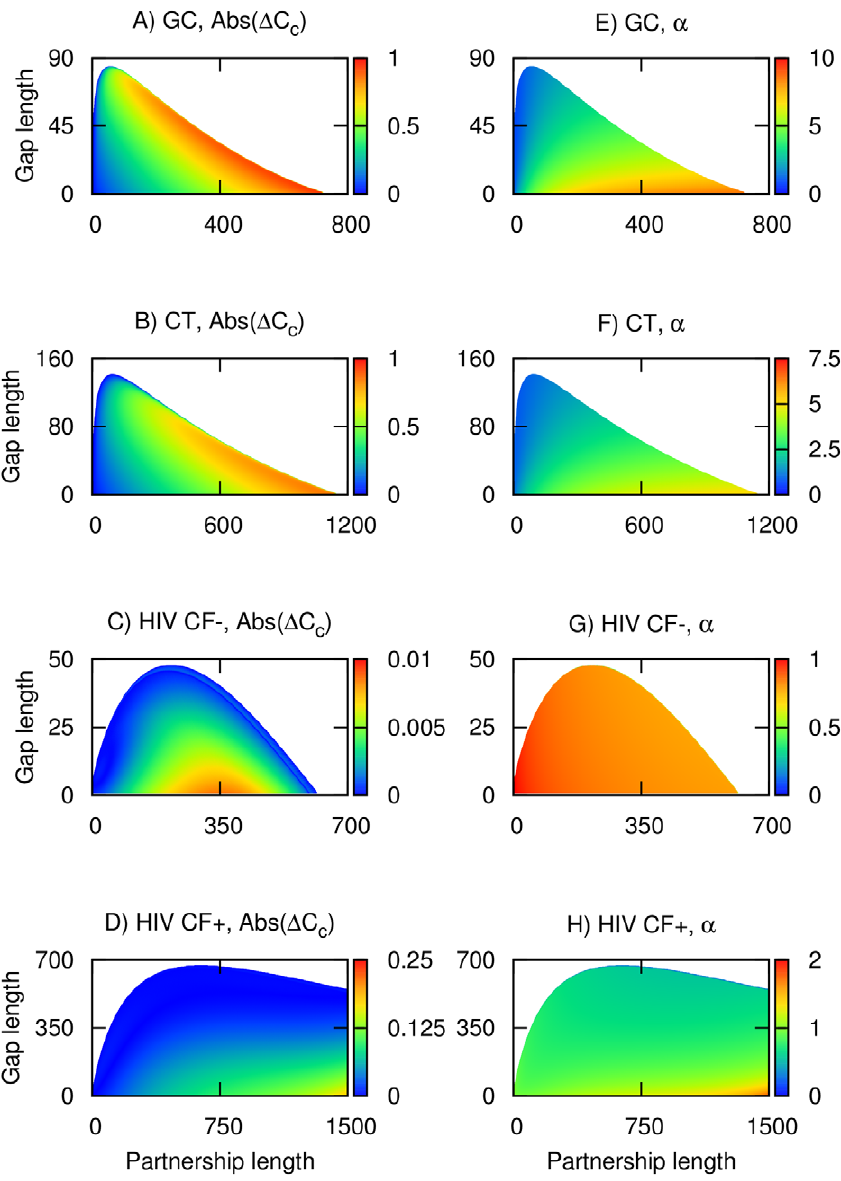
Figure 3. Absolute difference in predicted critical level of condom use (Abs( D C c )) for GC/CT and HIV with and without cofactor enhancement (A to D), with its corresponding adjustment factor, a (E to H). The horizontal axes give partnership length in days while the vertical axes give gap length in days. Abs( D C c ) is computed from the absolute difference in the corresponding values from Figure 2. Coloured bars in the left (A to D) and right (E to H) panels give the values of Abs( D C c ) and a by the respective gradient of